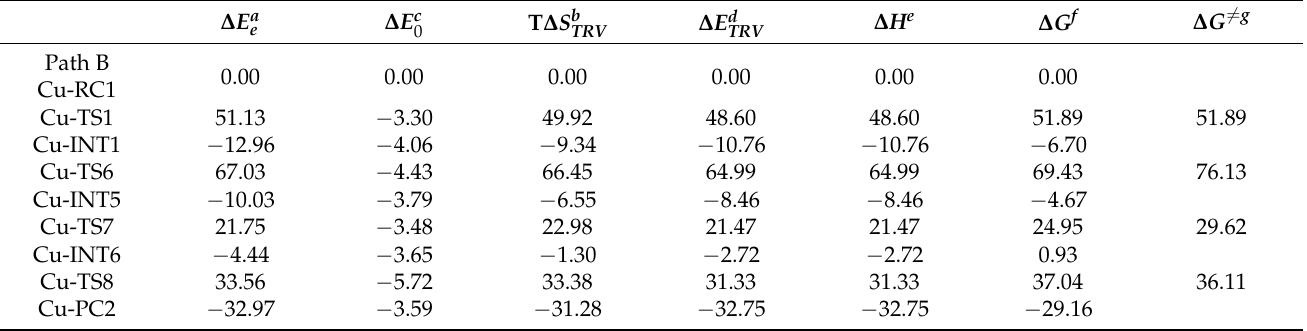
Table 2. Relative energies (in kcal/mol) with respect to the reactant complex (RC) for the